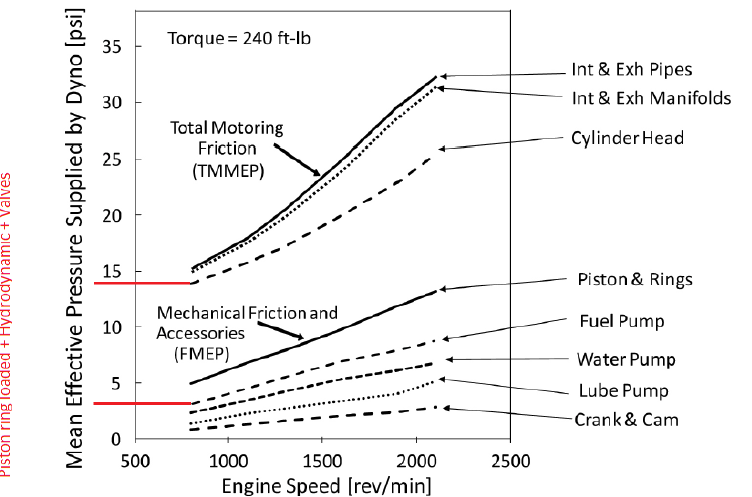
Figure A6. Tear down motoring figure copied from Stanton et al. [12]. When the cylinder head was removed, the valve train and the loading on the piston skirt and rings were also removed. The valve train and pumping are of course fairly small, and already partially contained in the removal of the manifolds. The graph erroneously labels the component as the “cylinder head”. It also needs to be remembered that the test shown is under motoring conditions. When the engine is idling and the PCP is about 20 to 30% higher, this energy loss will increase by about the same amount, while all the hydrodynamic and pumping losses will remain about the same. Under load, the loaded piston assembly term will of course grow even larger. The part of the graph shown as “Piston & Rings” represents the hydrodynamic portion of the piston assembly, plus the boundary friction of the oil control rings which is mostly unaffected by cylinder pressure. The RLE in this paper is believed to eliminate a large portion of the friction between the two red lines, plus the oil control boundary friction term.